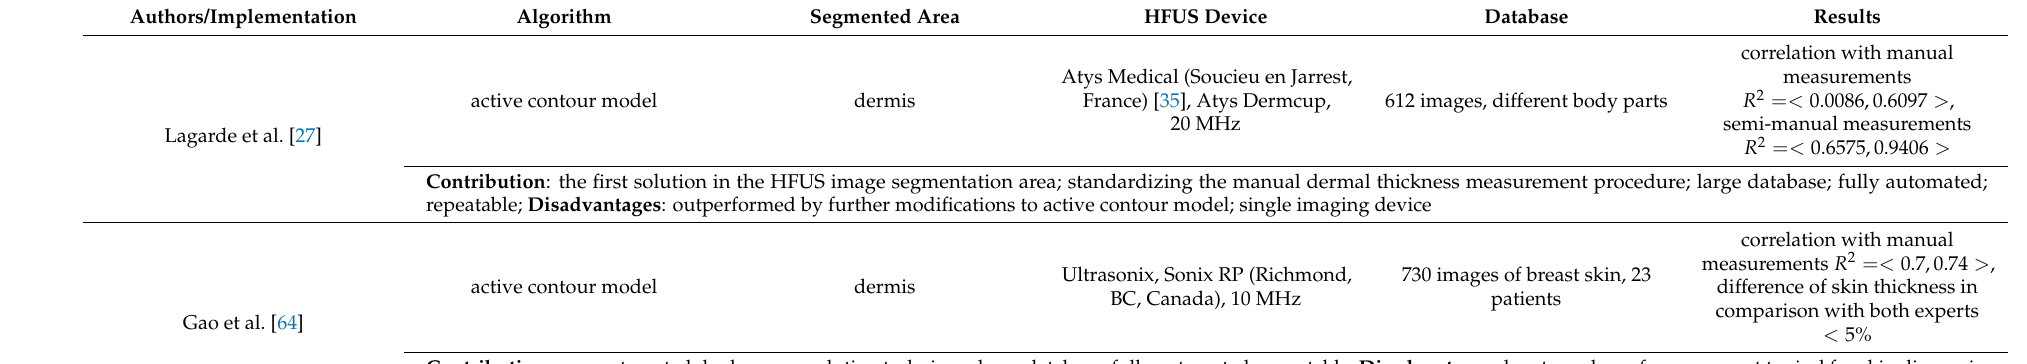
Table 4. Summary of skin layer segmentation algorithms for small, specific